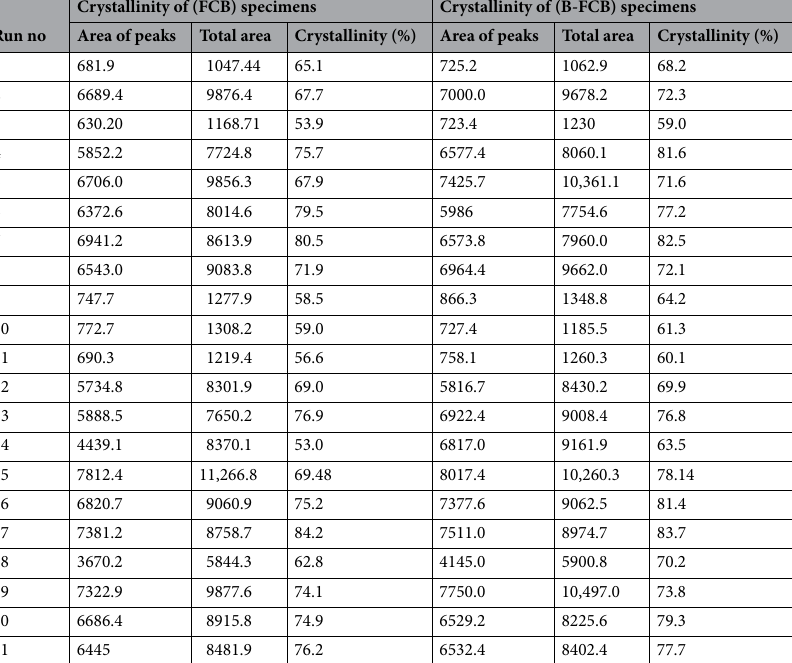
Table 5. Crystallinity percentage of FCB and